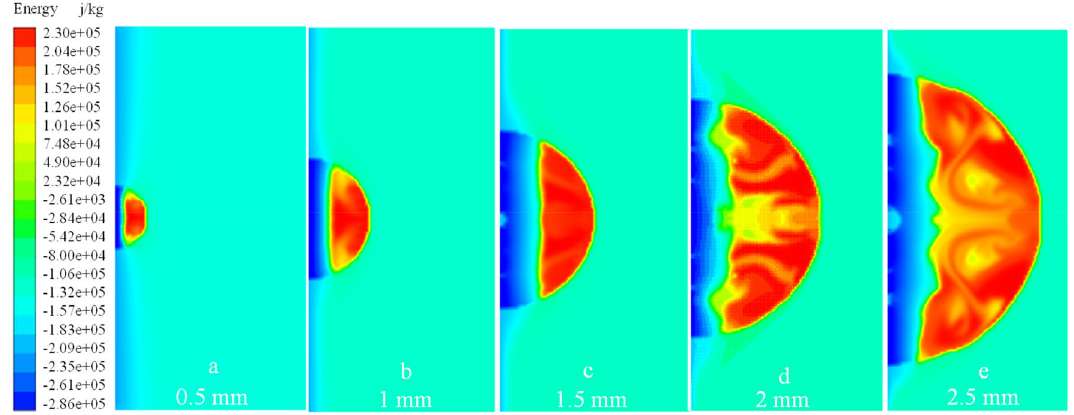
Figure 13. H-point for 267 K liquid drop internal energy.